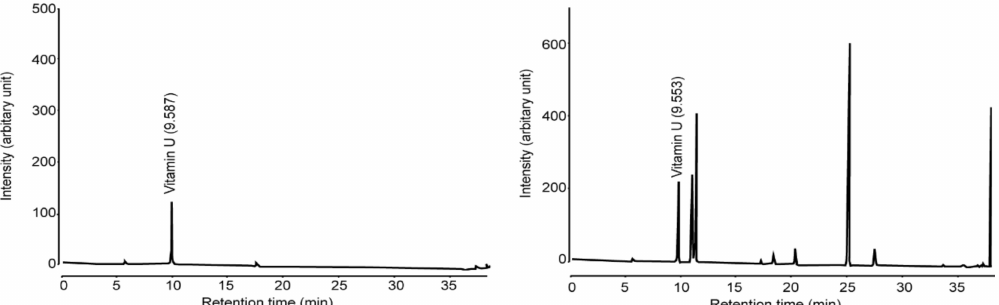
Figure 1. Representative chromatogram after eluting vitamin U (left) and BOE (right). BOE, B. oleracea var. capitata L.